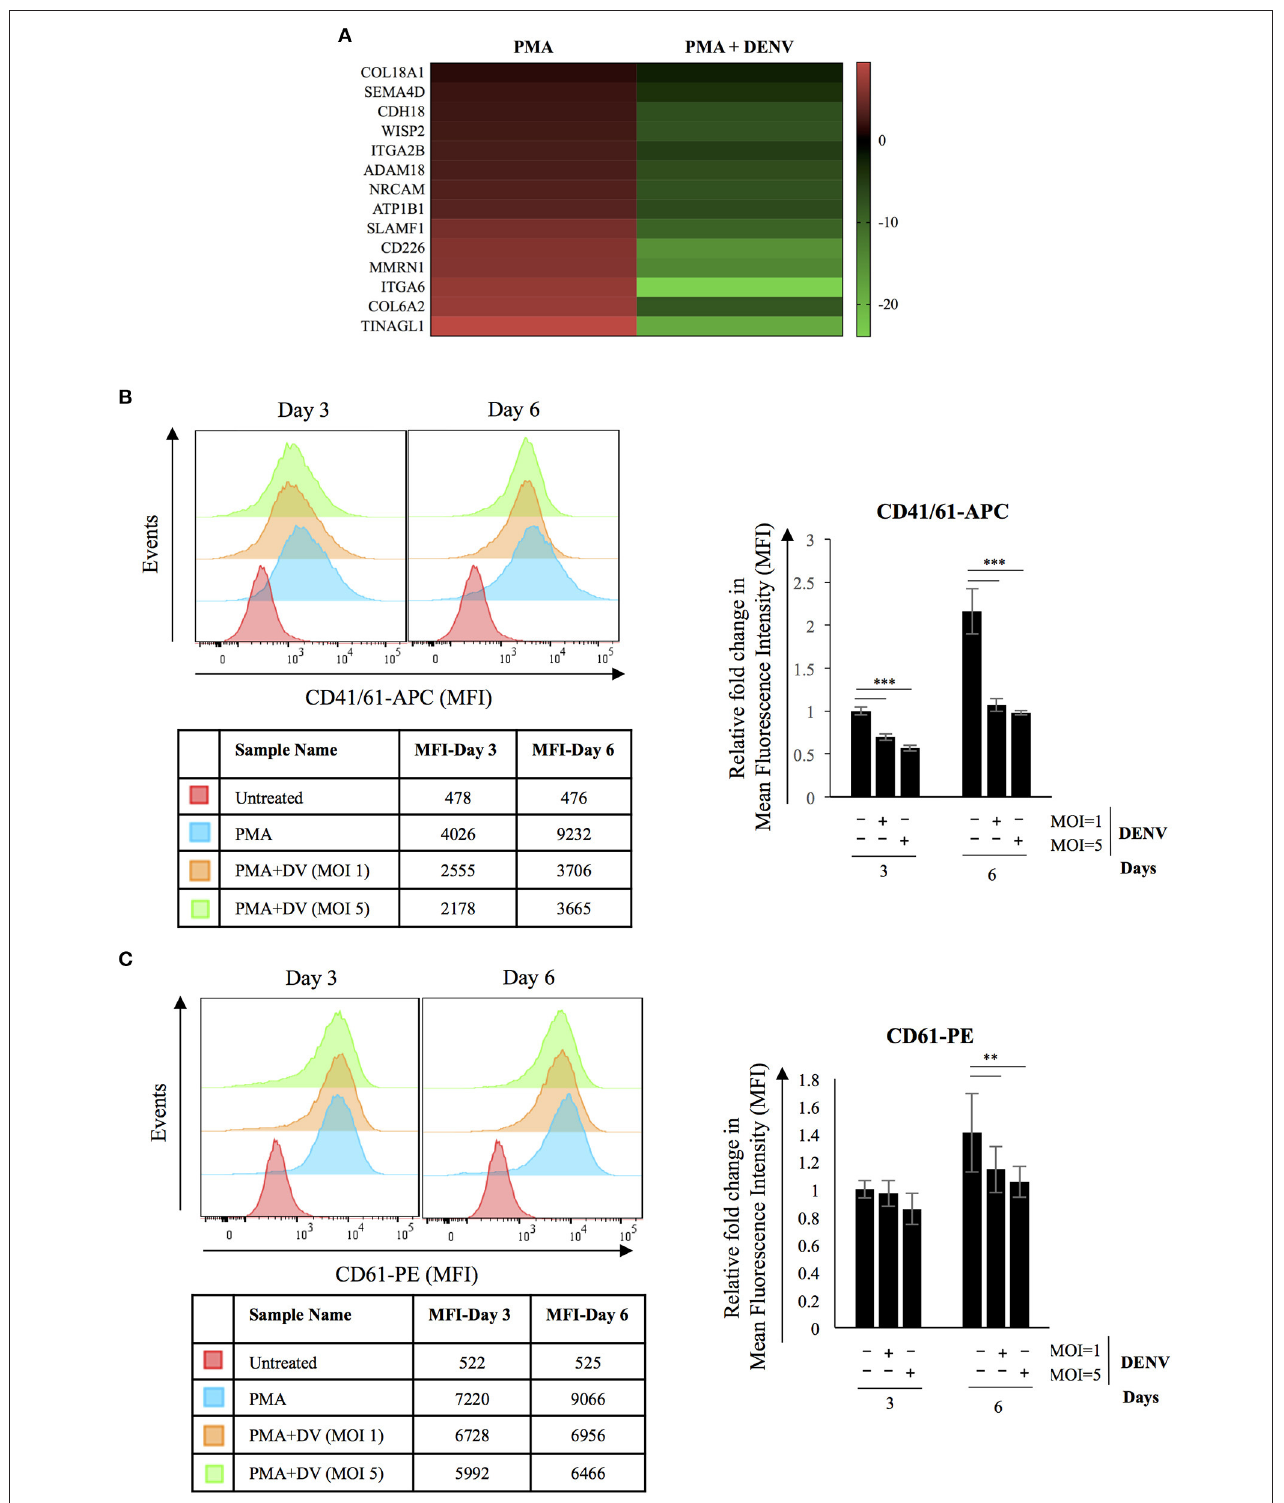
FIGURE 6 | DENV replication reduces expression of MK-specific surface markers in differentiating cells. (A) Heatmap showing transcriptional downregulation of genes associated with GO biological process; Cell Adhesion (GO: 0007155) in infected cells differentiated with PMA for 6 days when compared to uninfected controls. (B,C) K562 cells either uninfected or infected with DENV at the indicated MOI were differentiated with PMA. At 3 or 6 days post-infection, the surface expression of the